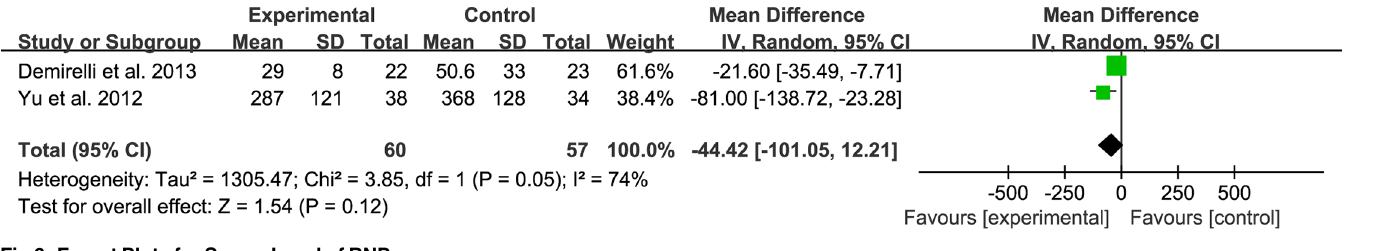
S3 Fig. Meta-Regression of Multivessel Disease on Rates of Elevated cTnI > 2 Times